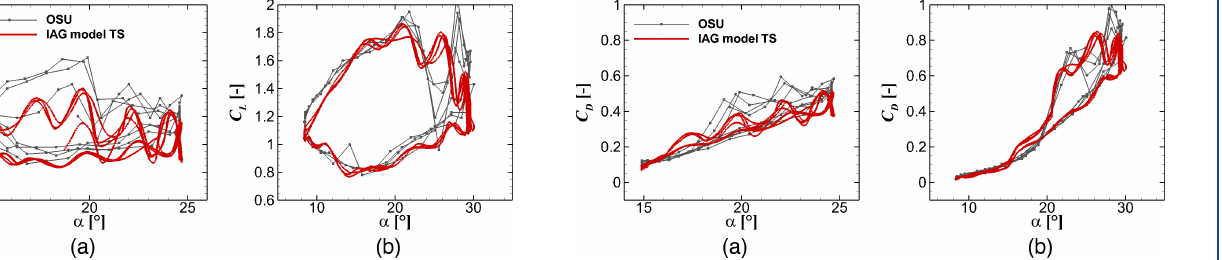
Figure 21. Drag reconstruction by the IAG model in comparison with the measurement data (Ramsay et al., 1996) for (cid:49)t = T/ 1440 using the actual angle of attack in the experimental campaign at various (cid:49)α values. (a) (cid:49)α = 5 . 5 ◦ ; (b) (cid:49)α = 10 ◦ . S801 airfoil, k = 0 . 073 and α = 20 ◦